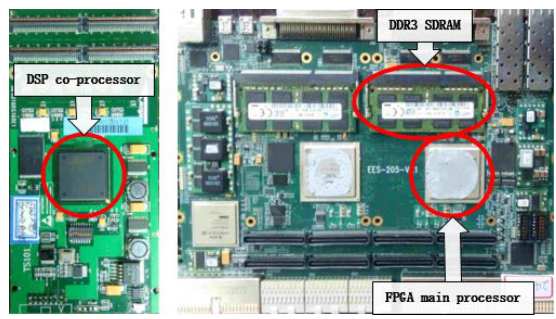
Figure 13. Photo of the hardware system.